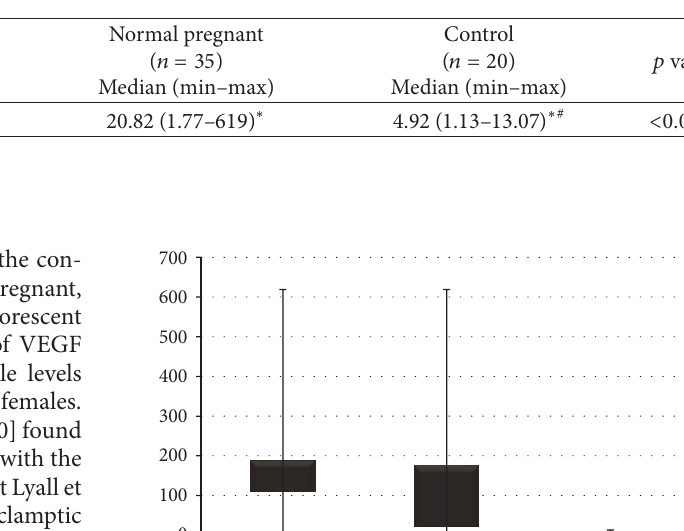
Table 2: Levels of serum VEGF in PIH, normal pregnant, and control subjects.